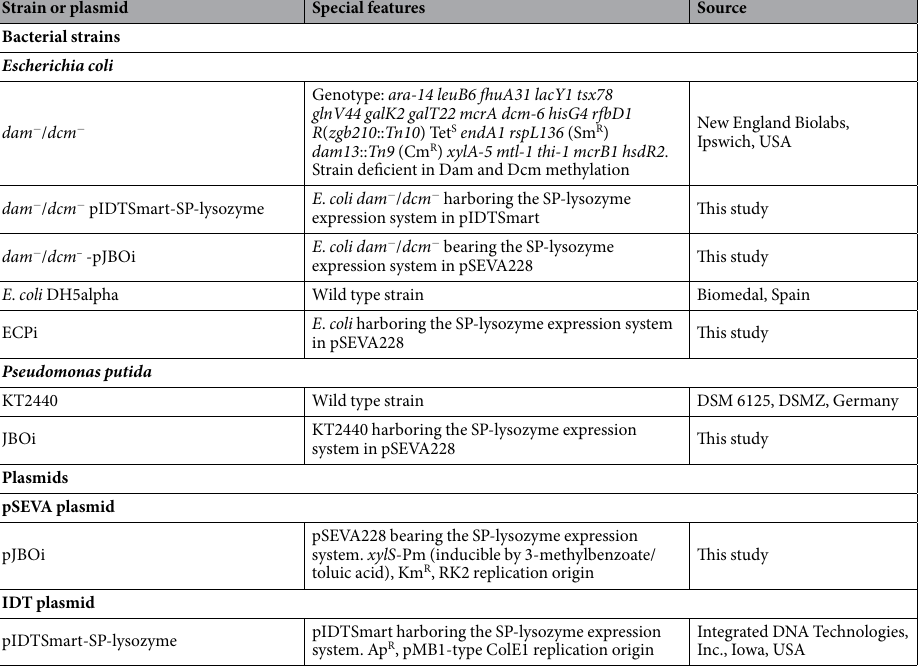
Table 1. Strains and plasmid used in this study. Ap R = Ampicillin resistance; Km R = Kanamycin resistance; Sm R = Streptomycin resistance; Cm R = Chloramphenicol